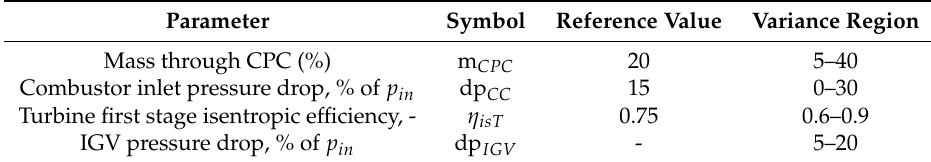
Table 4. Values of the parameters for the sensitivity